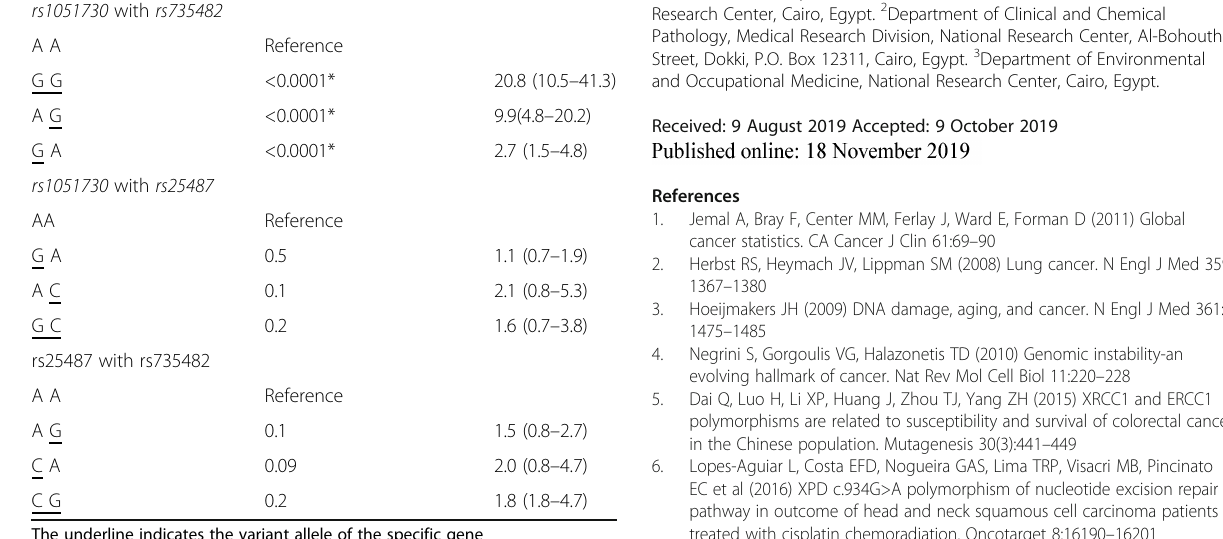
Table 6 Gene-gene interaction in lung cancer patients Haplotype